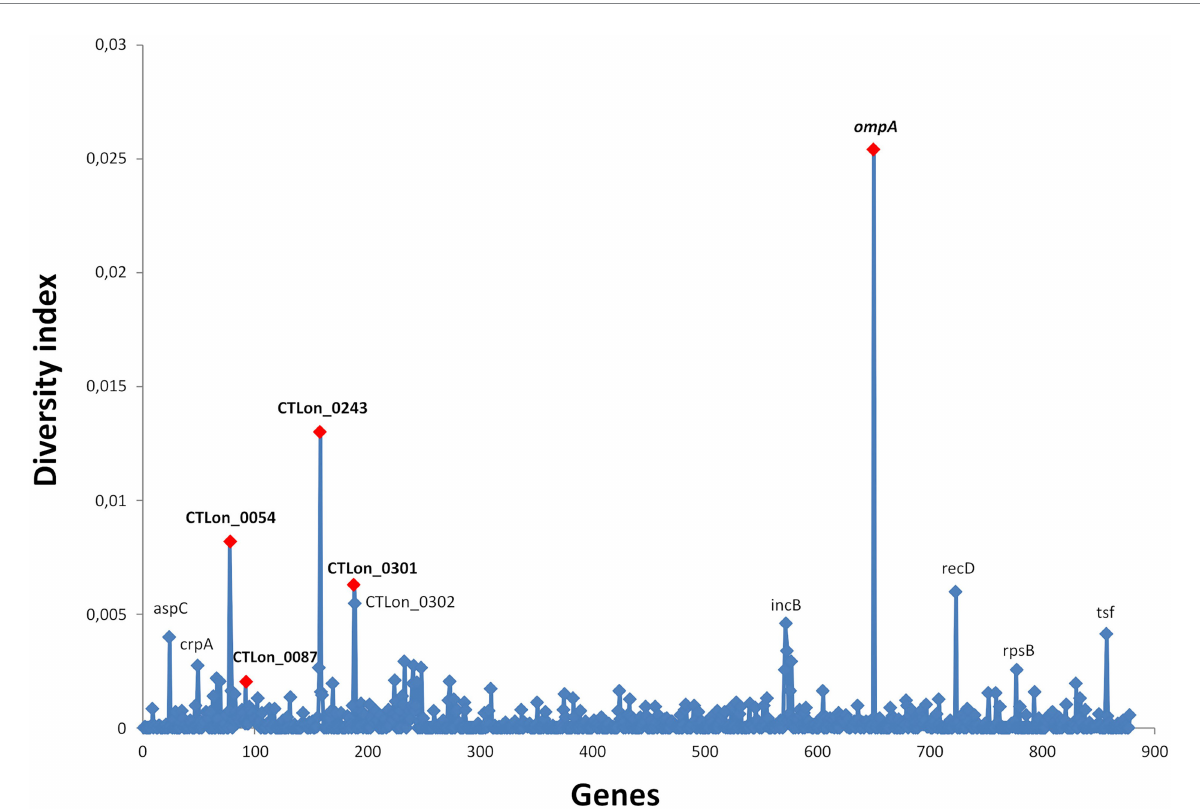
FIGURE 1 Mean evolutionary diversity (D index) of the core-genome of L-genotypes of Chlamydia trachomatis . A total of 878 genes were analyzed using the Tamura-Nei model. The selected genes for this study are marked in